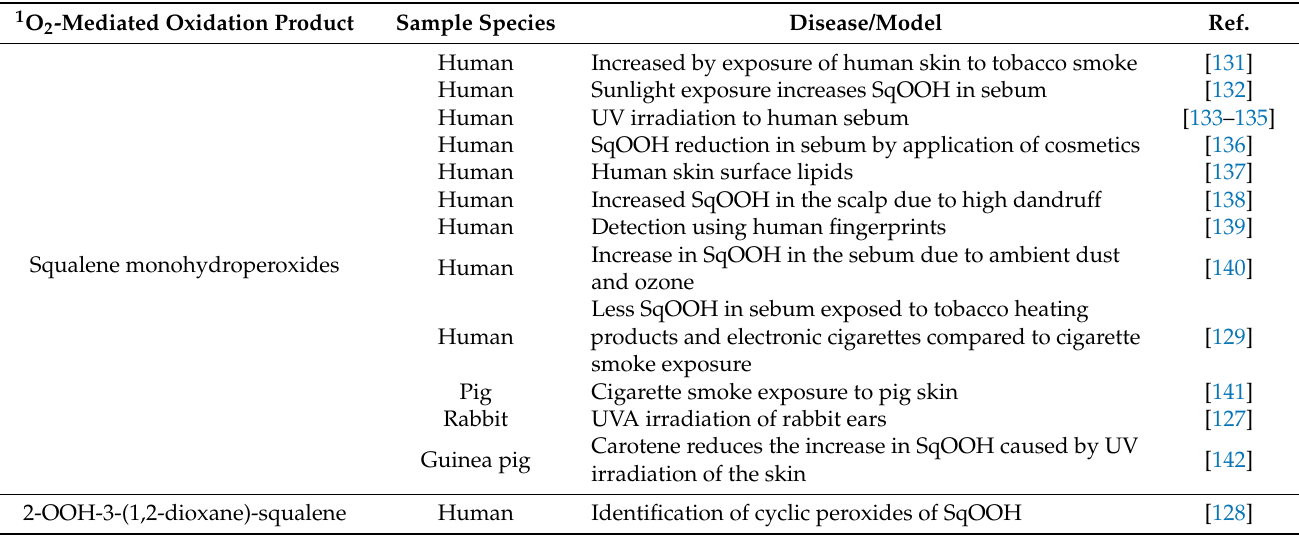
Table 3. Report on the results of the determination of squalene-derived peroxides produced by oxidation reactions mediated by 1 O 2 using human and animal